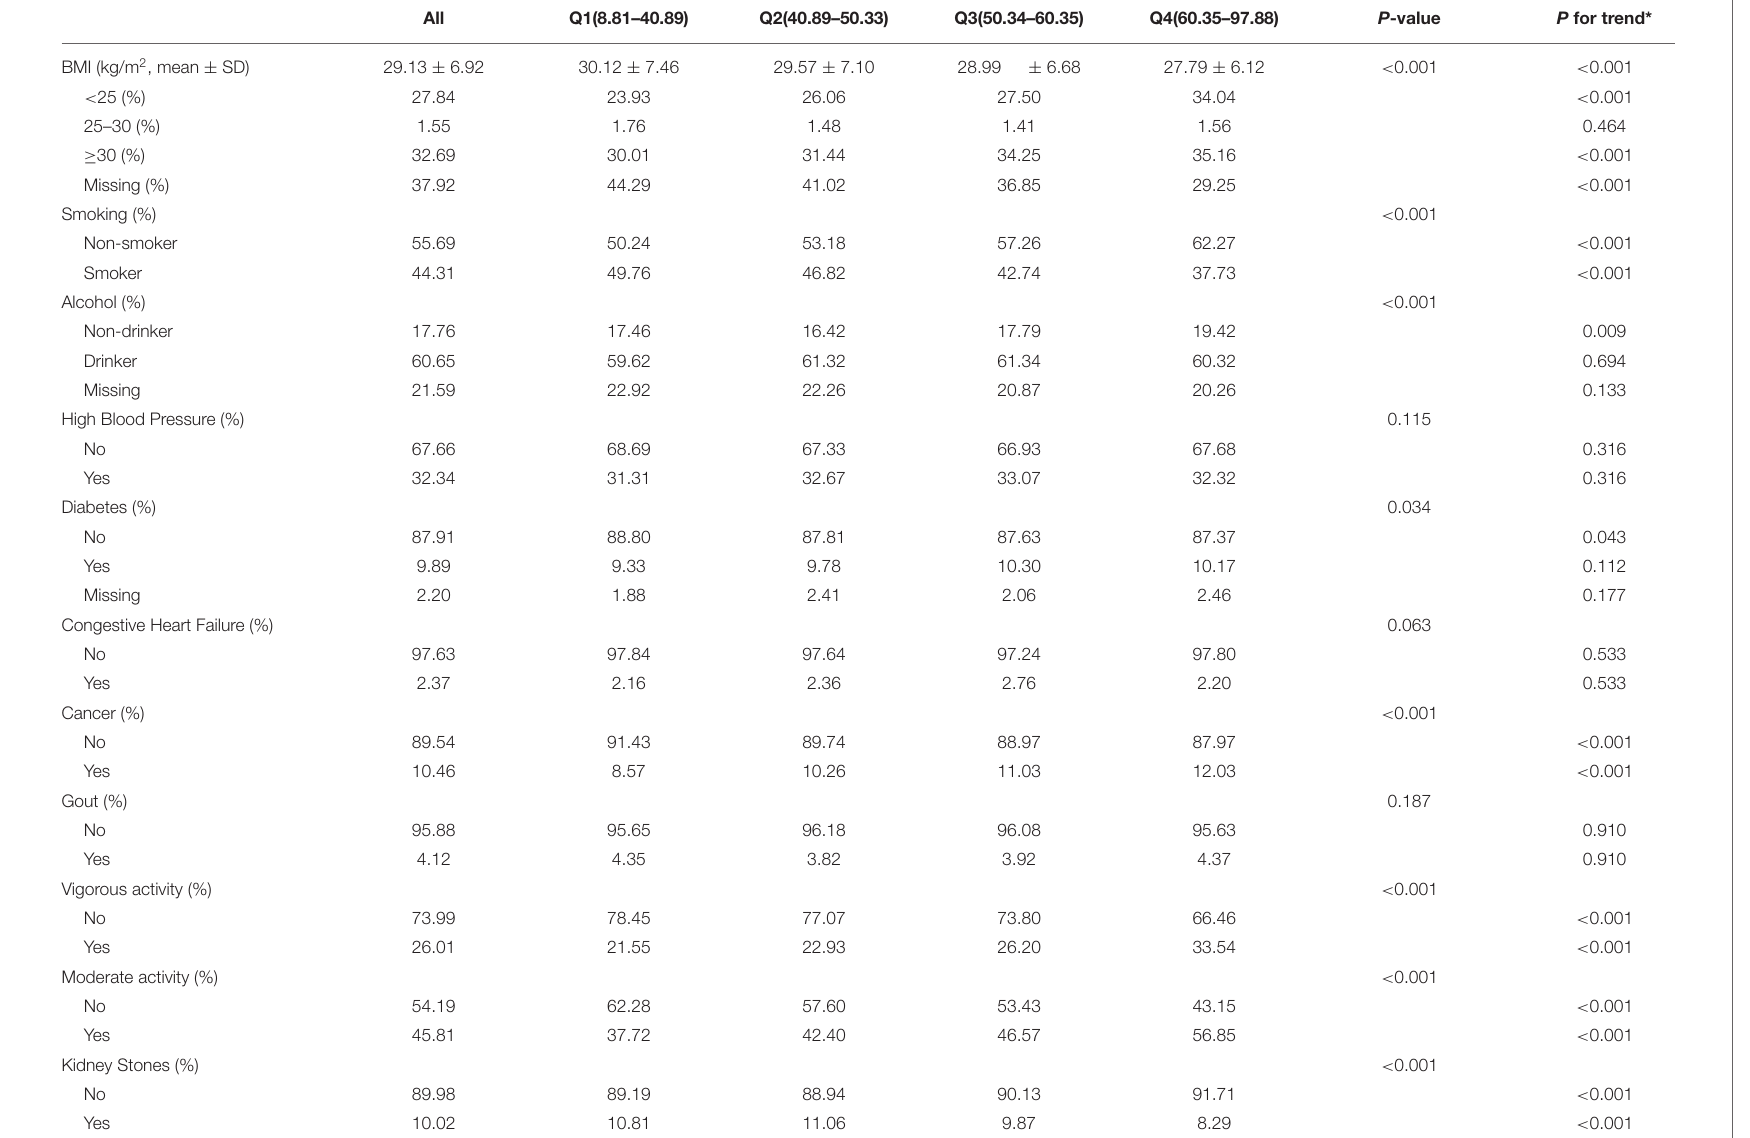
Mean ± SD for continuous variables, P-value was by survey-weighted linear regression. % for categorical variables, P-value was by survey-weighted Chi-square test. * P for trend was by fitting a logistic regression